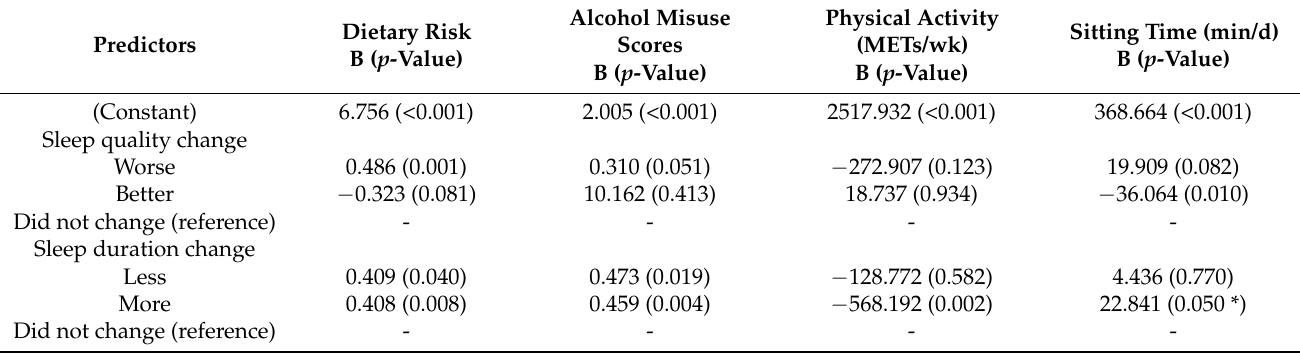
Table 7. Outcomes of linear regression models examining whether sleep changes were related to health behaviors.